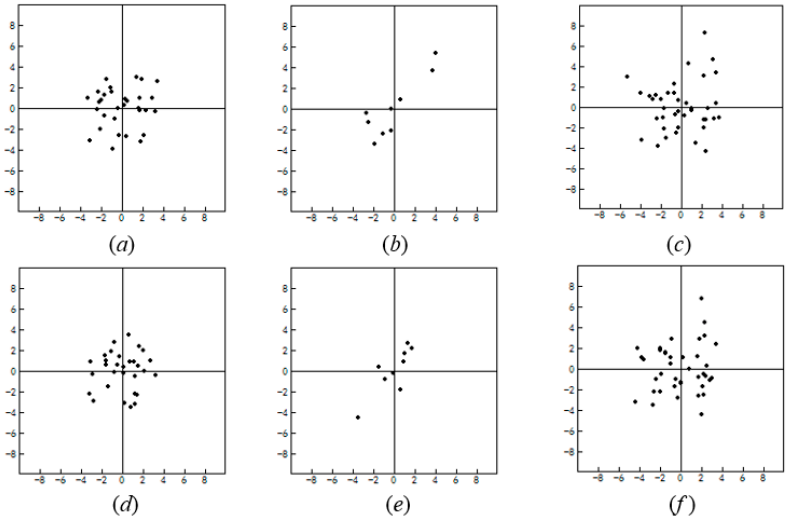
Figure 8. ( a – f ) Control point residuals. The first and second rows correspond to 1st-order and 2nd-order polynomial models, respectively. Left ( a ) and ( d ) SC, middle ( b ) and ( e ) SIFT, right ( c ) and ( f )